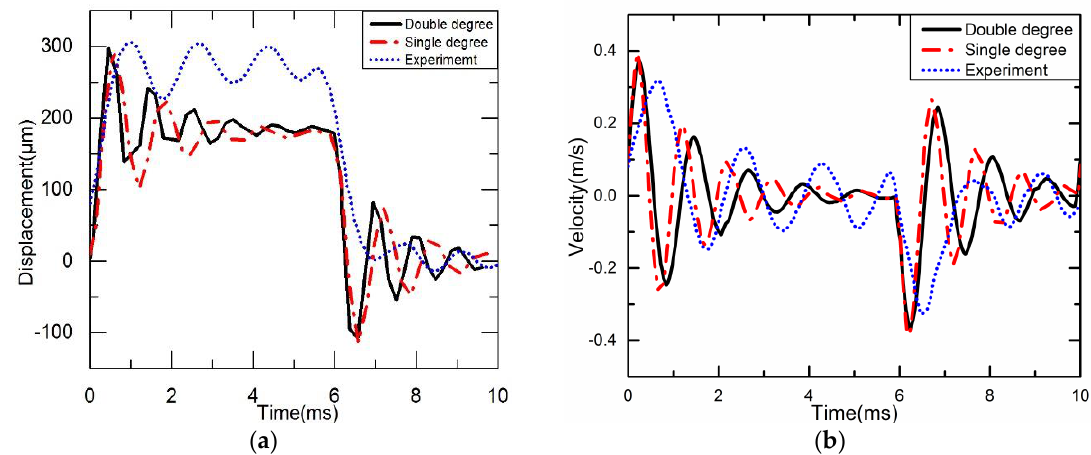
Figure 11. Dynamic characteristics of the needle: ( a ) The vertical displacement graph; ( b ) The vertical